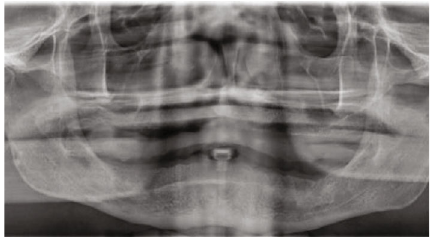
Figure 1: Preoperatory panoramic radiograph.